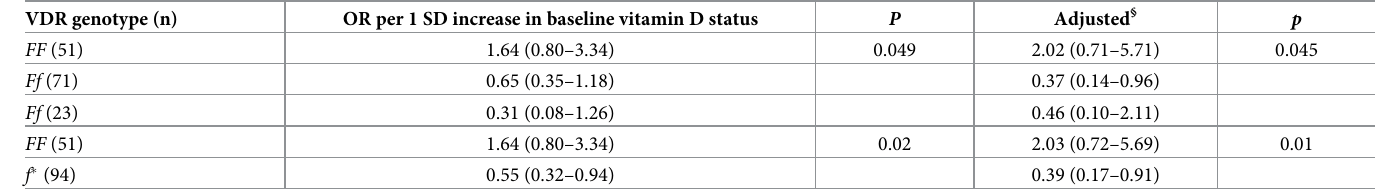
Table 2. Logistic regression for stress fracture including vitamin D receptor (VDR) x baseline vitamin D status interaction. VDR genotype